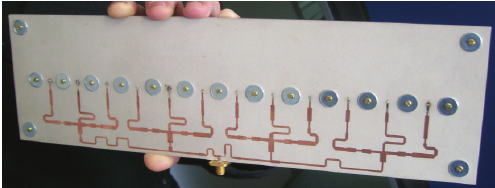
Figure 7: The feed network is designed to maximize the e ffi ciency of the strongly coupled